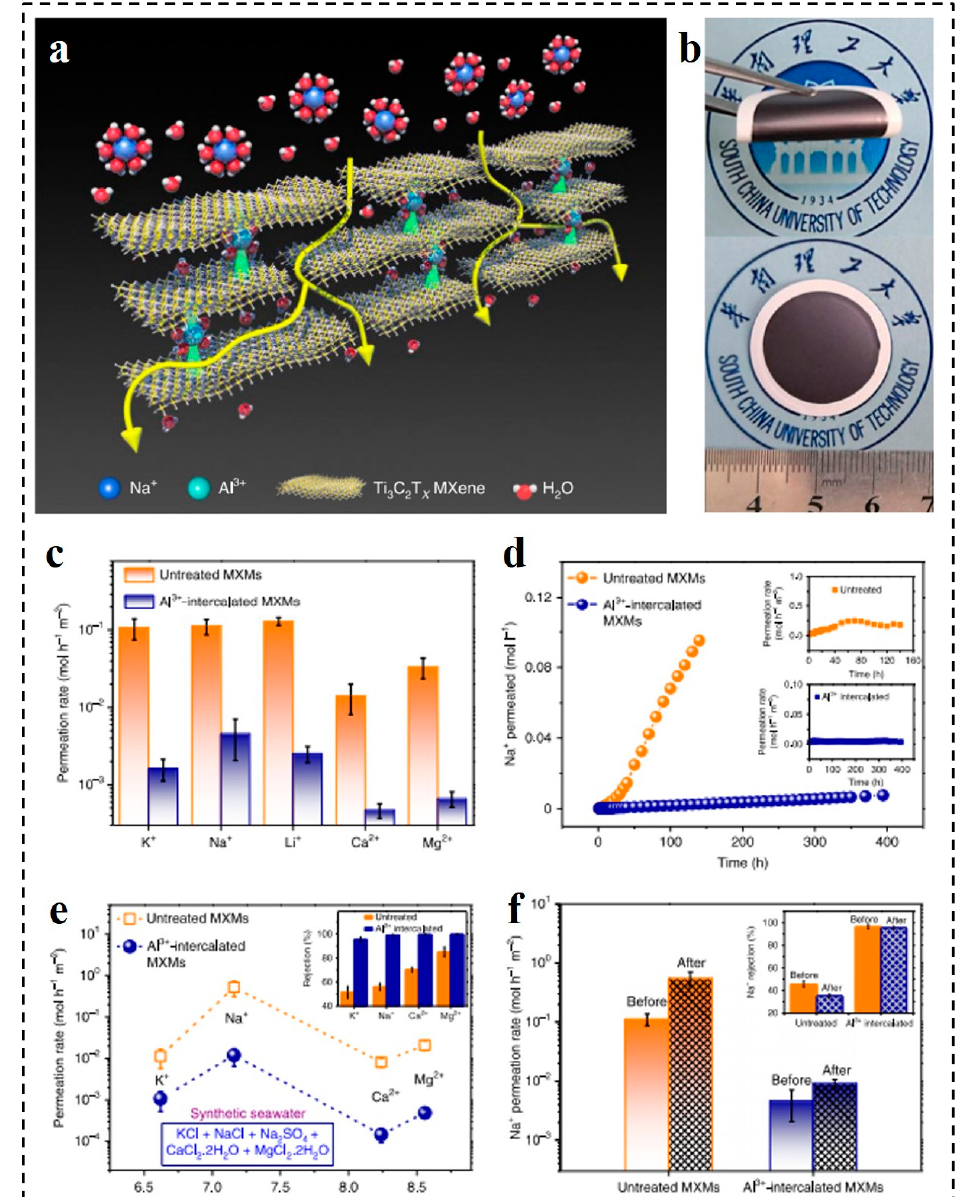
Figure 2. Ti 3 C 2 Tx MXene membranes (MXM): ( a ) Schematic representation of Al 3+ intercalation between two adjacent MXene layers and thus a fixed d-spacing. The hydrated cation such as Na+ are rejected and the water molecules can permeate through the MXM. ( b ) Digital photos of untreated MXM and its blending state. ( c – f ) The ion permeation rate and DI permeance ( c ); time-dependent Na + permeation ( d ); comparison of the rates of ions in synthetic seawater ( e ); chlorine resistance ( f ); of untreated MXMs and Al 3+ -intercalated MXMs. Reprinted with permission from [86]. Copyright 2020 Nature Publishing Group.